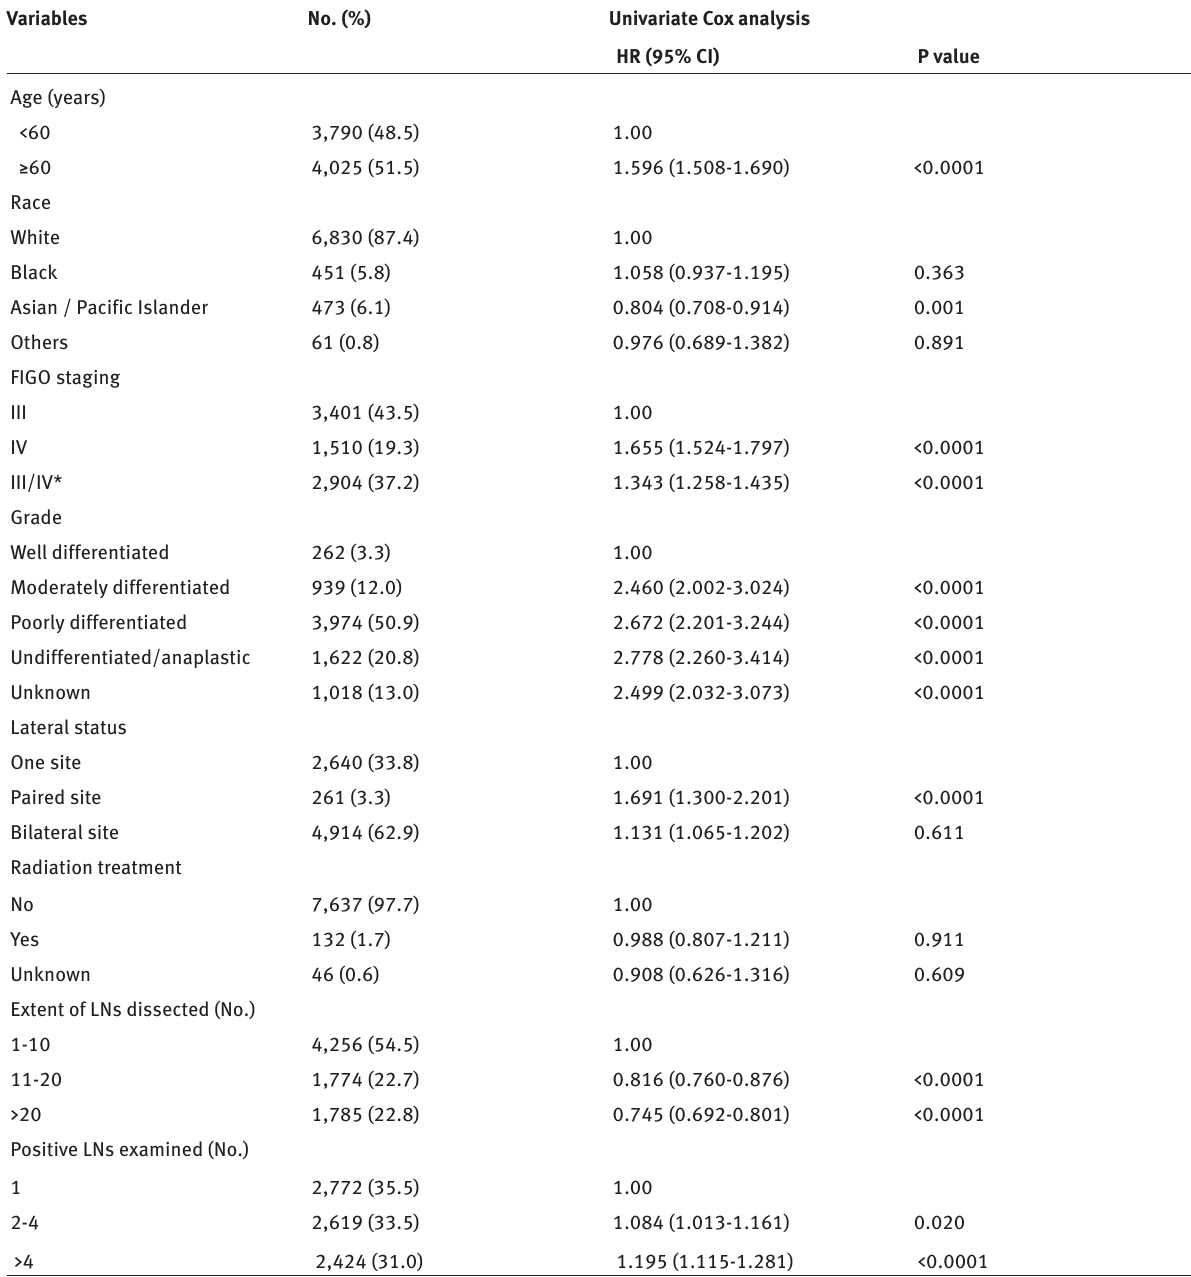
Table 1 : Baseline characteristics and associations with overall survival in SEOC patients